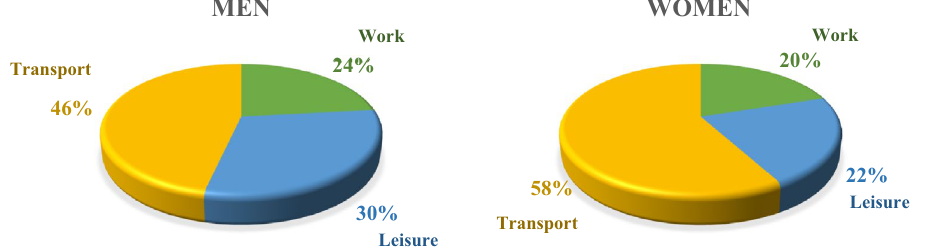
Figure 1. Percentage by domain of physical activity.